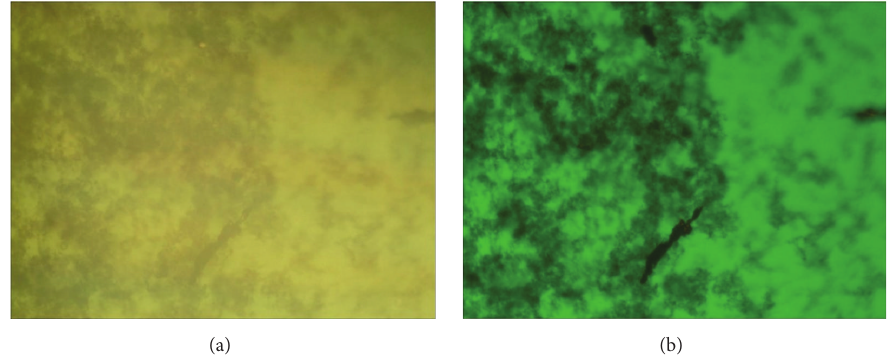
Figure 7: Photos of ferrographic record for sample D: (a) bottom light, (b) upper light.